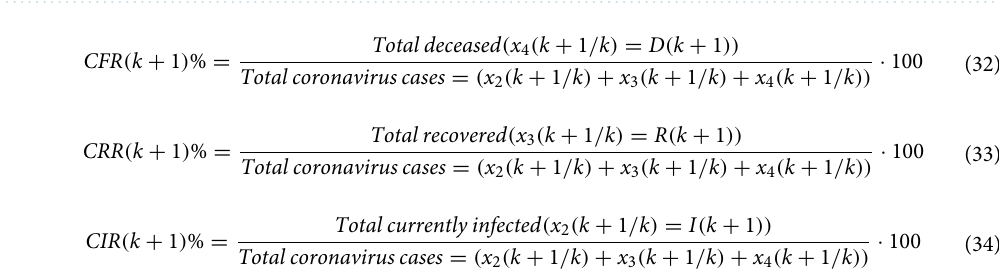
Figure 8a, b and c show the real and predicted trajectories of daily new coronavirus cases, daily new deceased and daily new recovered, from these trajectories it shown that the EKF is correctly predicted these daily new quantities. The good results obtained by the application of the EKF on the coronavirus evolution using SIRD model are demonstrated by the smaller RMSEs (Root mean square errors) of daily new coronavirus cases, daily new deceased and daily new recovered, illustrated in Fig. 9a, b and c. These RMSEs are obtained from 100 Monte Carlo runs given by the equation: